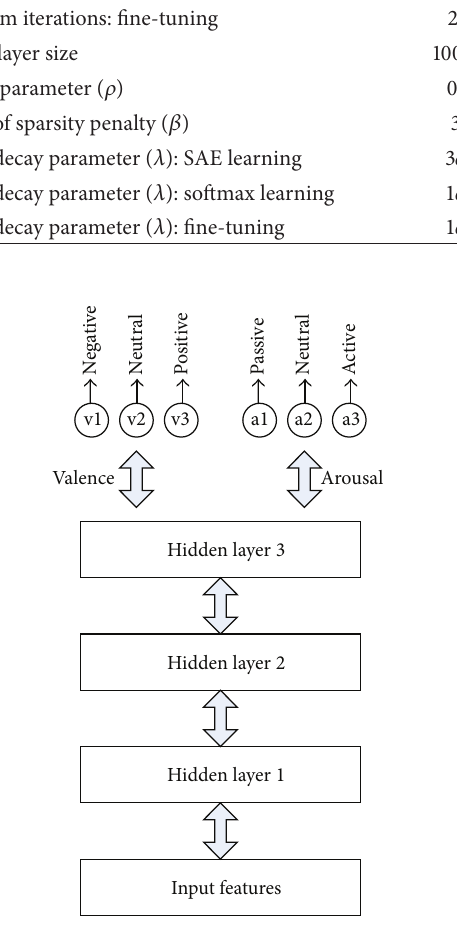
Figure 9: DLN with two softmax